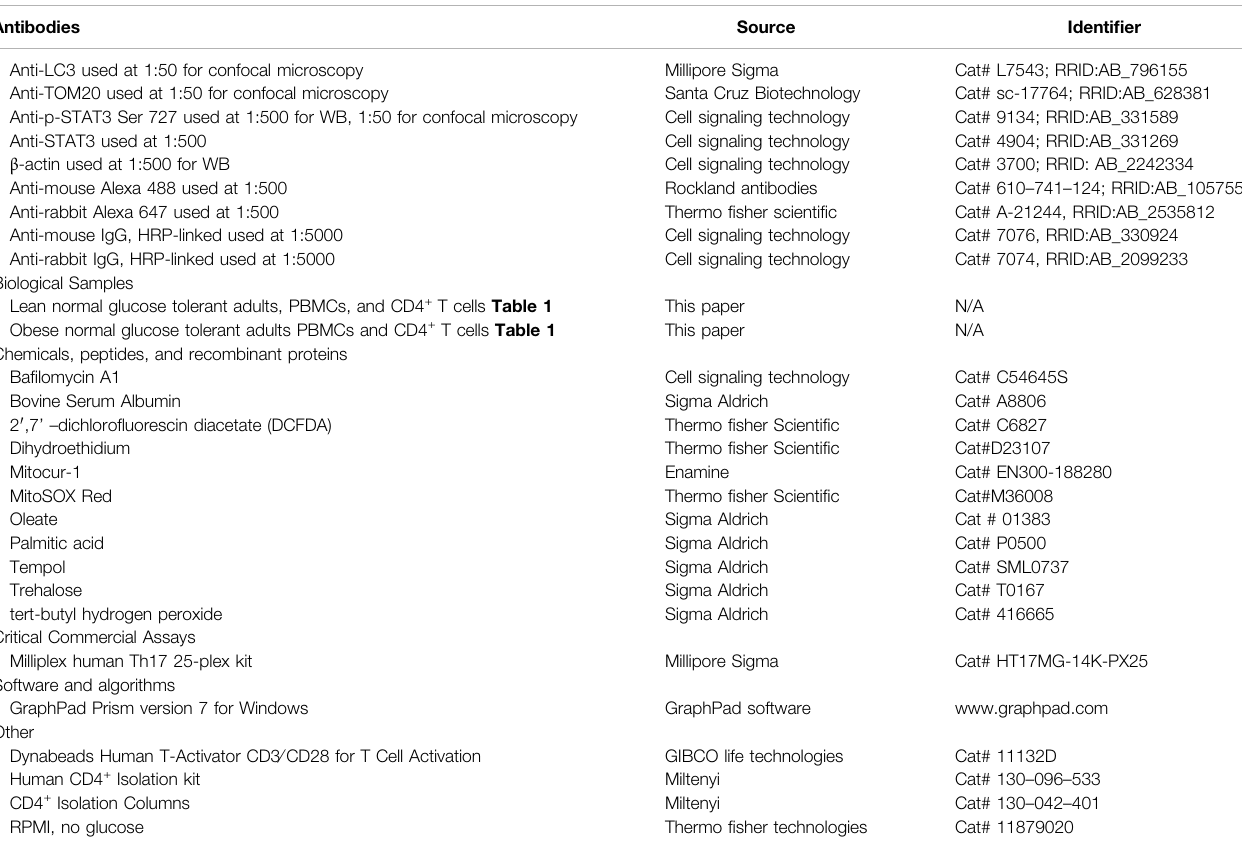
TABLE 2 | Reagent or resource.